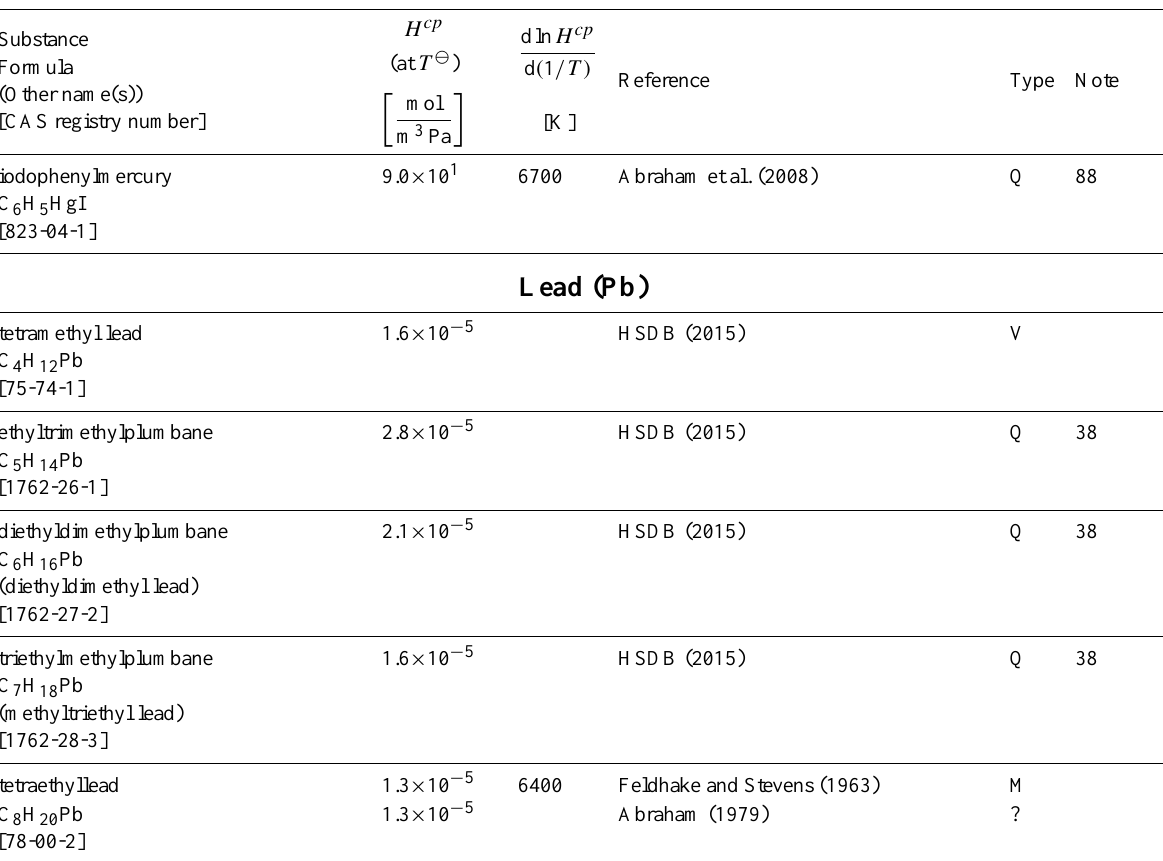
Table 6: Henry’s law constants for water as solvent